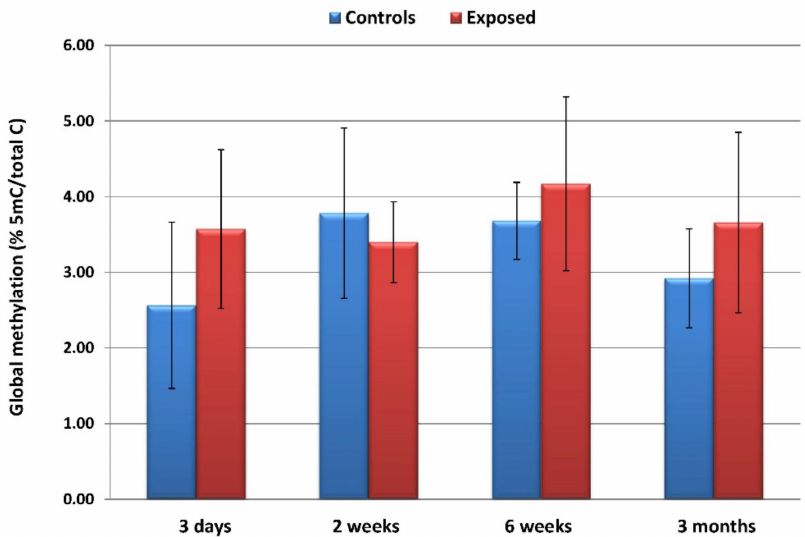
Figure 4. The average ( ± SD) global DNA methylation levels reported as a proportion of 5-methylcytosine / total cytosine in the exposed and control